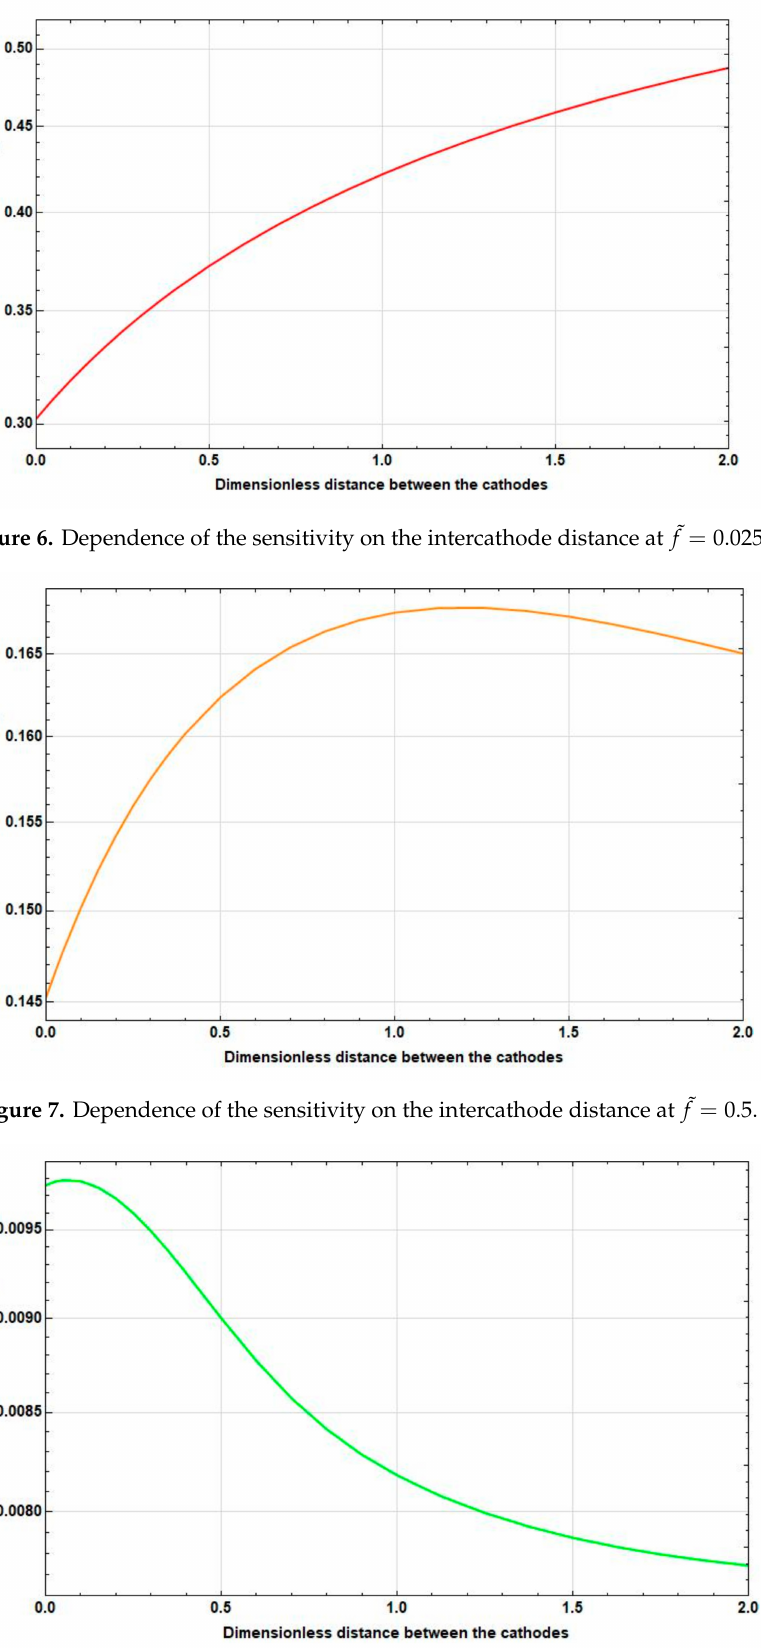
Figure 8. Dependence of the sensitivity on the intercathode distance at ˜ f =